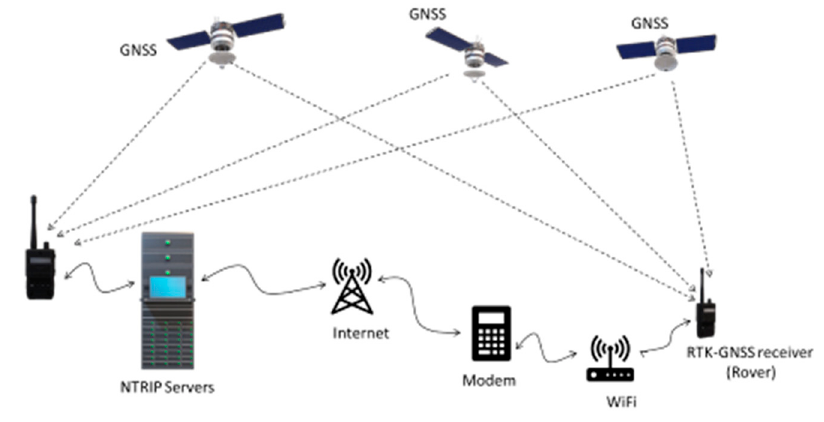
Figure 3. Context diagram of the Network Transport of RTCM via Internet Protocol (NTRIP).